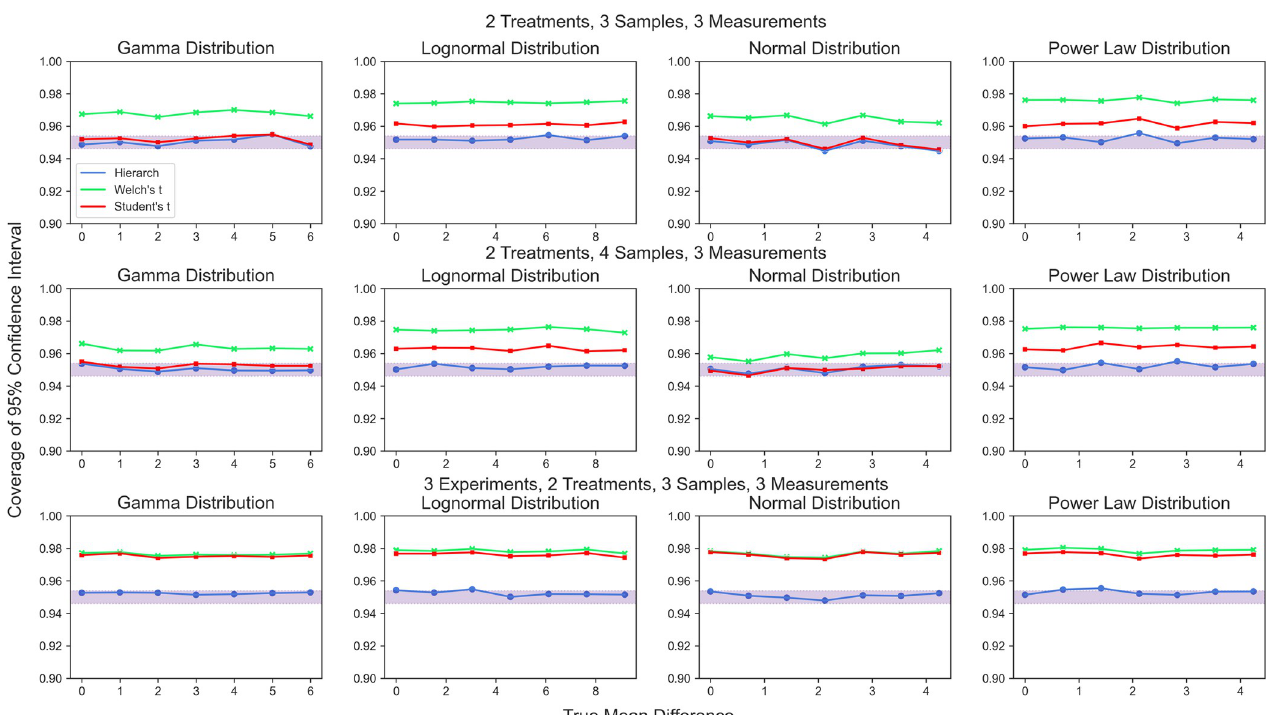
Fig 12. Coverage probability of 95% confidence intervals generated by test inversion. Shaded area represents the 95% binomial confidence interval around a 95% coverage probability.